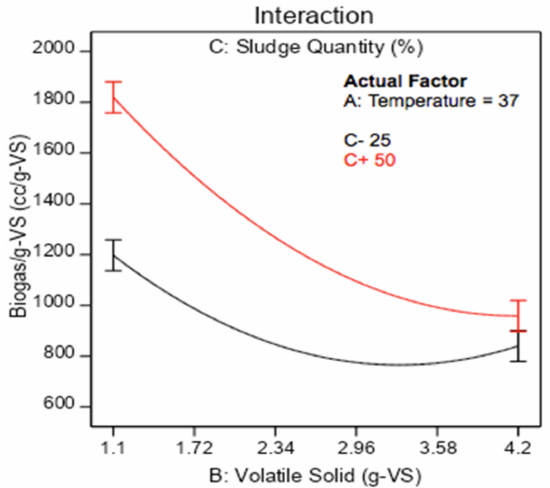
Figure 9. Interaction plot clarifies the effect of interaction between volatile solid and sludge quantity on Biogas/g-VS.